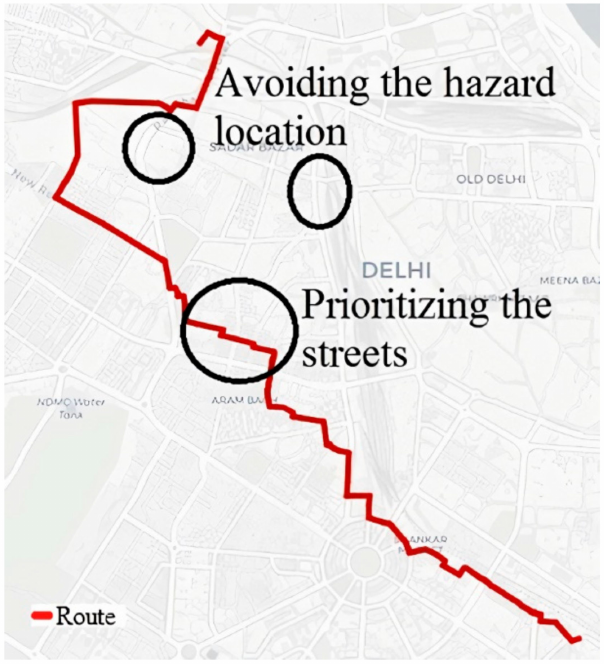
Figure 5. Map visualization and highlighted